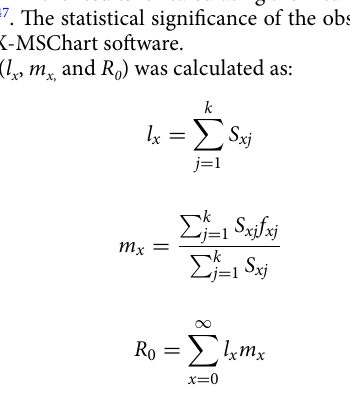
laid eggs were separated daily for each couple. The experiment was performed under controlled conditions of 25 ± 2 °C temperature, 65 ± 5% R.H. and 16:8 h (L:D) photoperiod. Life table analysis. Using raw data, the stage mean, age-stage–specific survival rate ( s xj ), age-stage repro- ductive value ( v xj ), age-stage–specific fecundity ( f xj ), age-stage life expectancy ( e xj ), age-specific survival rate ( l x ), age-specific fecundity ( m x ), age-specific net maternity ( l x m x ), and life table parameters ( R 0 , net reproductive rate; r , intrinsic rate of increase; λ , finite rate of increase; and T, mean generation time) were calculated using TWO- SEX-MSChart program 47 . The quick paired bootstrapping (Paired 1 by 1) technique with 100,000 replications was used to minimize the variation in the results for calculating the mean and standard error of the population 48 by TWOSEX-MSChart program 47 . The statistical significance of the observed differences between three